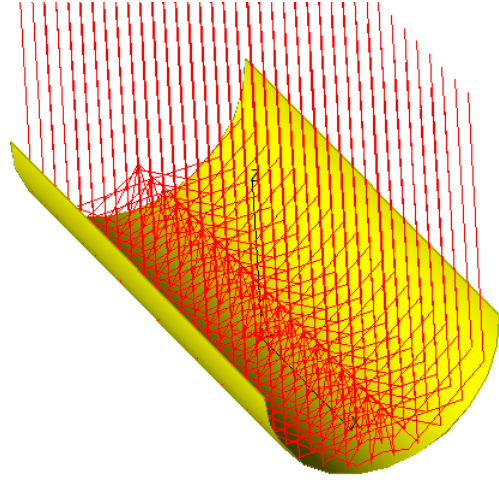
Figure 4. Illustration of the reflection law.